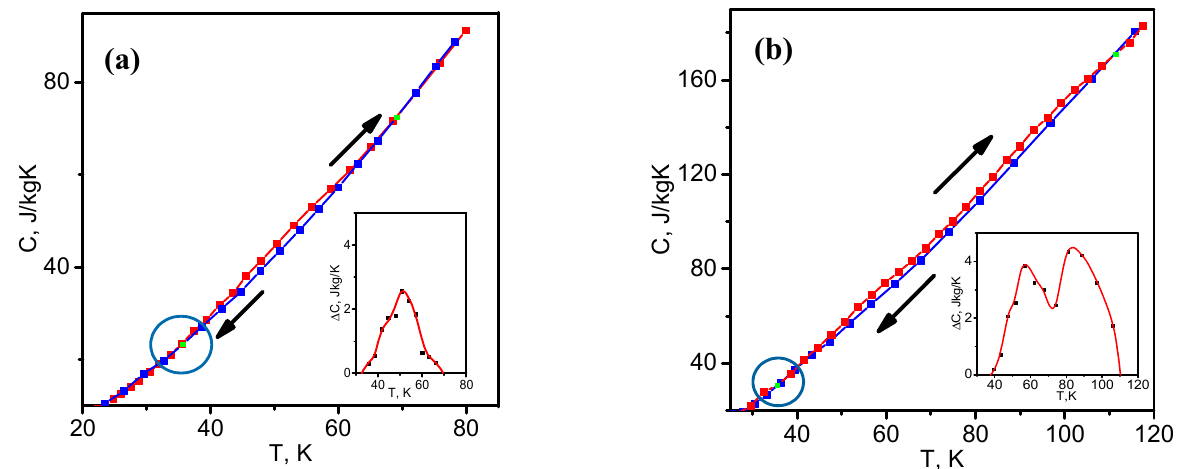
Figure 5. Heat capacity of samples S1 ( a ) and S2 ( b ) in heating (red curves) and cooling (blue curves). Hysteresis of heat capacity Δ С ( Т ) is given in the insets, and a region near the hysteresis onset temperature during the heating–cooling process is circled.